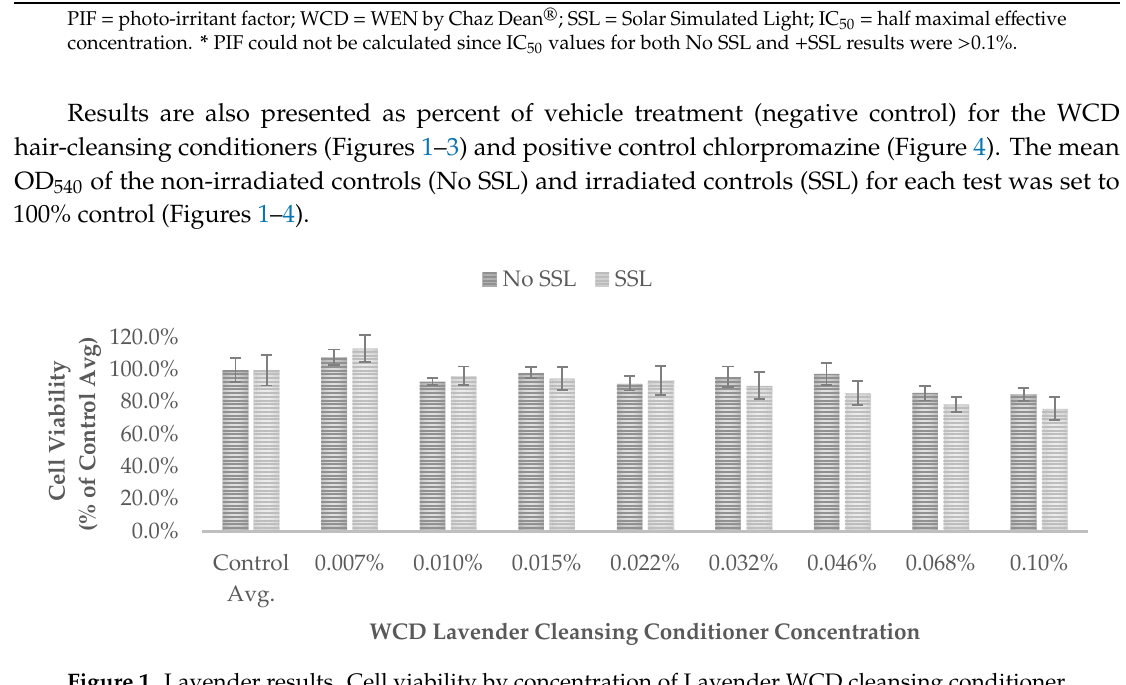
Figure 1. Lavender results. Cell viability by concentration of Lavender WCD cleansing conditioner, stratified by with and without solar simulated light (SSL).